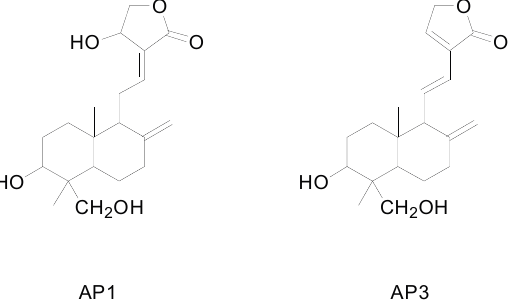
Figure 1. The chemical structure of andrographolide (AP 1 ) and dehydroandrographolide (AP 3 ). Heat reflux extraction (HRE) is the most widely used conventional technique for the extraction of diterpenoids from A. paniculata . However, HRE causes the consumption of large amounts of volatile and hazardous organic solvents, and needs long extraction times and consumes more energy.